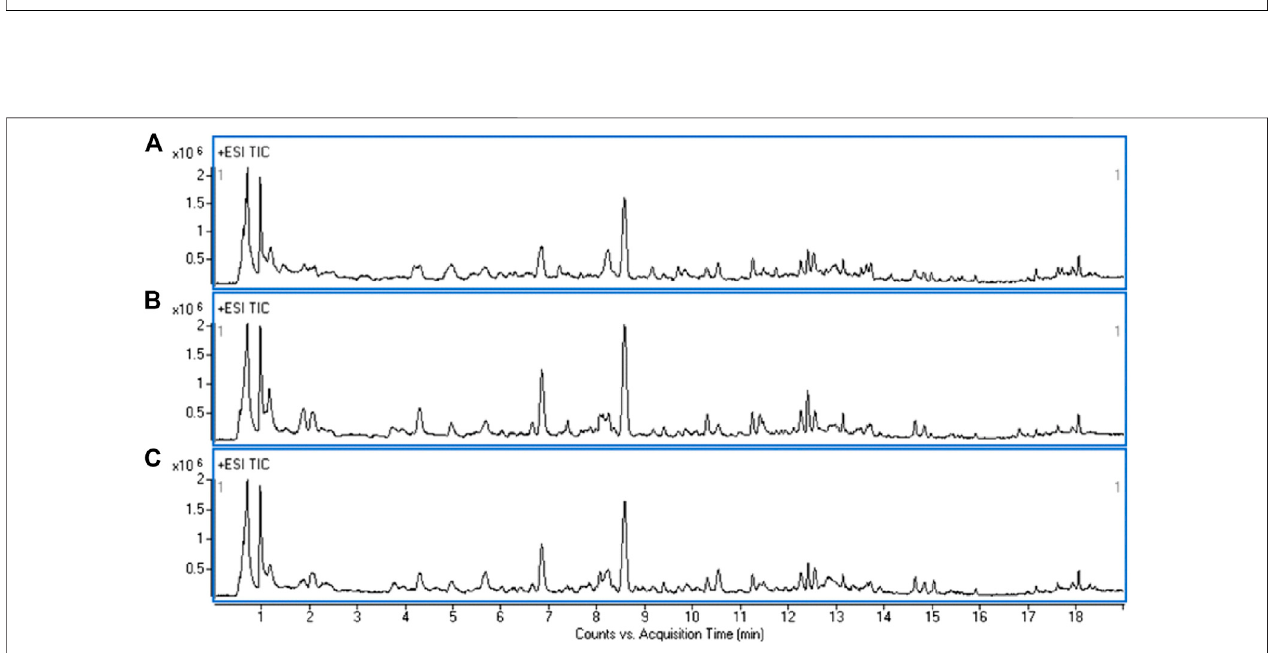
FIGURE 3 | Representative TIC obtained for the ESI-positive ion in the control group (A) , oxalate group (B) and oxalate + high-dose GS group (C) .